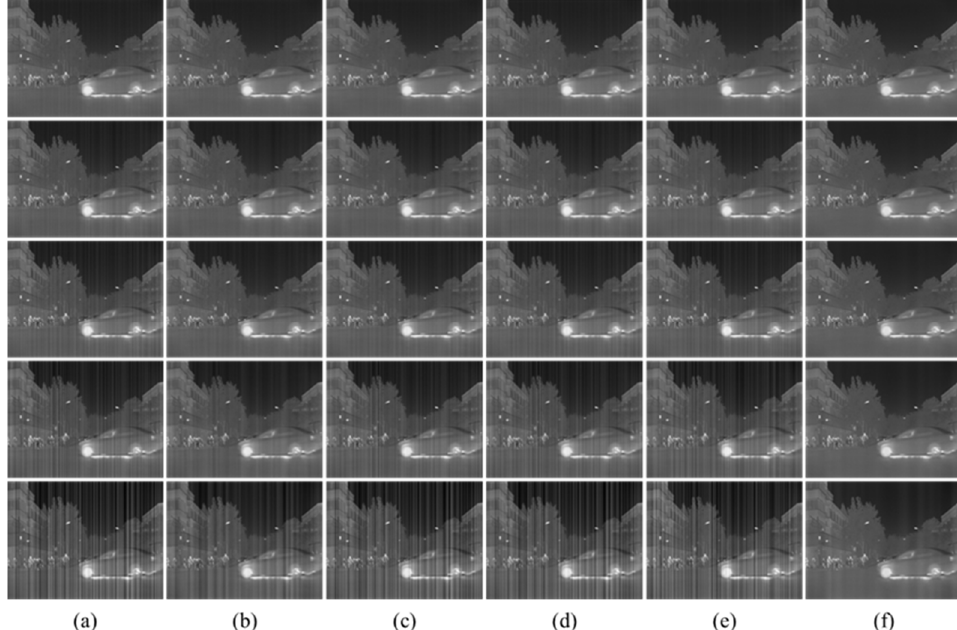
Figure 7. The NUC results of different methods for different intensity noise. ( a ) The noise infrared images with different intensity (the noise intensity is 0.01, 0.02, 0.03, 0.05, 0.10 from top to bottom); ( b ) 1DGF [33]; ( c ) SNRCNN [15]; ( d ) DLS-NUC [16]; ( e ) ICSRN [17]; ( f ) Our method.